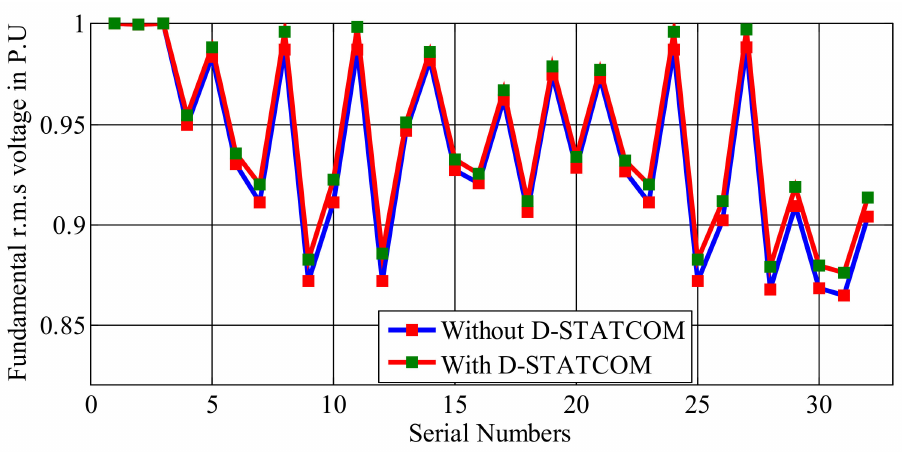
Figure 9. Comparison of fundamental r.m.svoltages for case studies on IEEE − 13 URDN.